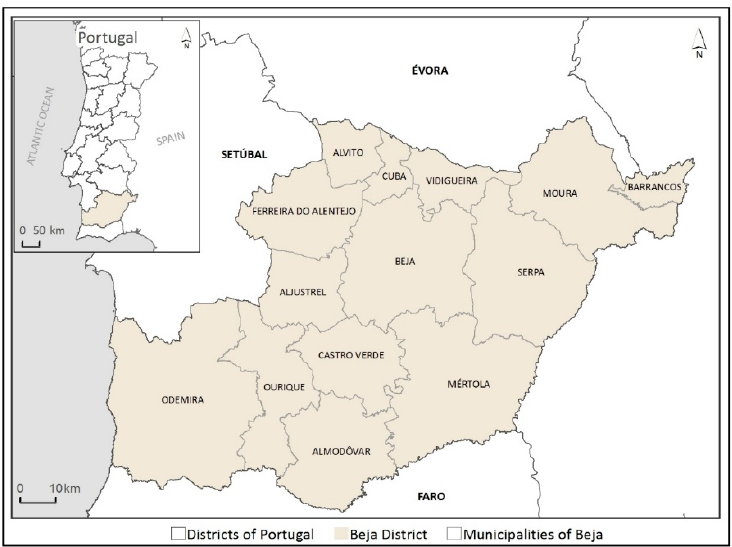
Figure 1. Location of Beja District and its Municipalities.